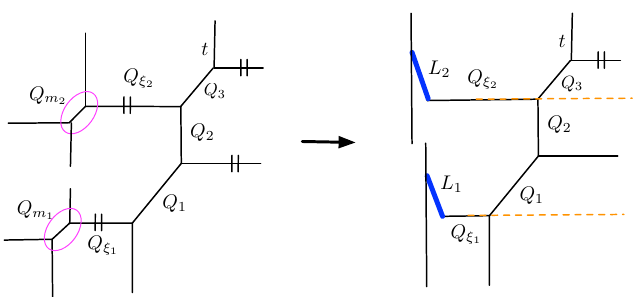
Figure 20 . Implementing geometric transitions introduces D3-branes L 1 and L 2 . In the topological vertex method, cutting lines means associated Young diagrams are set to be empty.